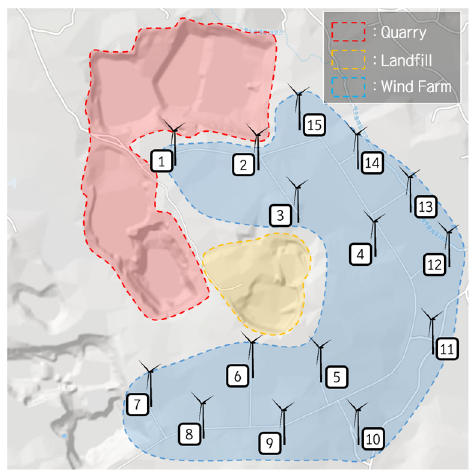
Figure 1. Geographical characteristics in the vicinity of Dongbok wind farm.